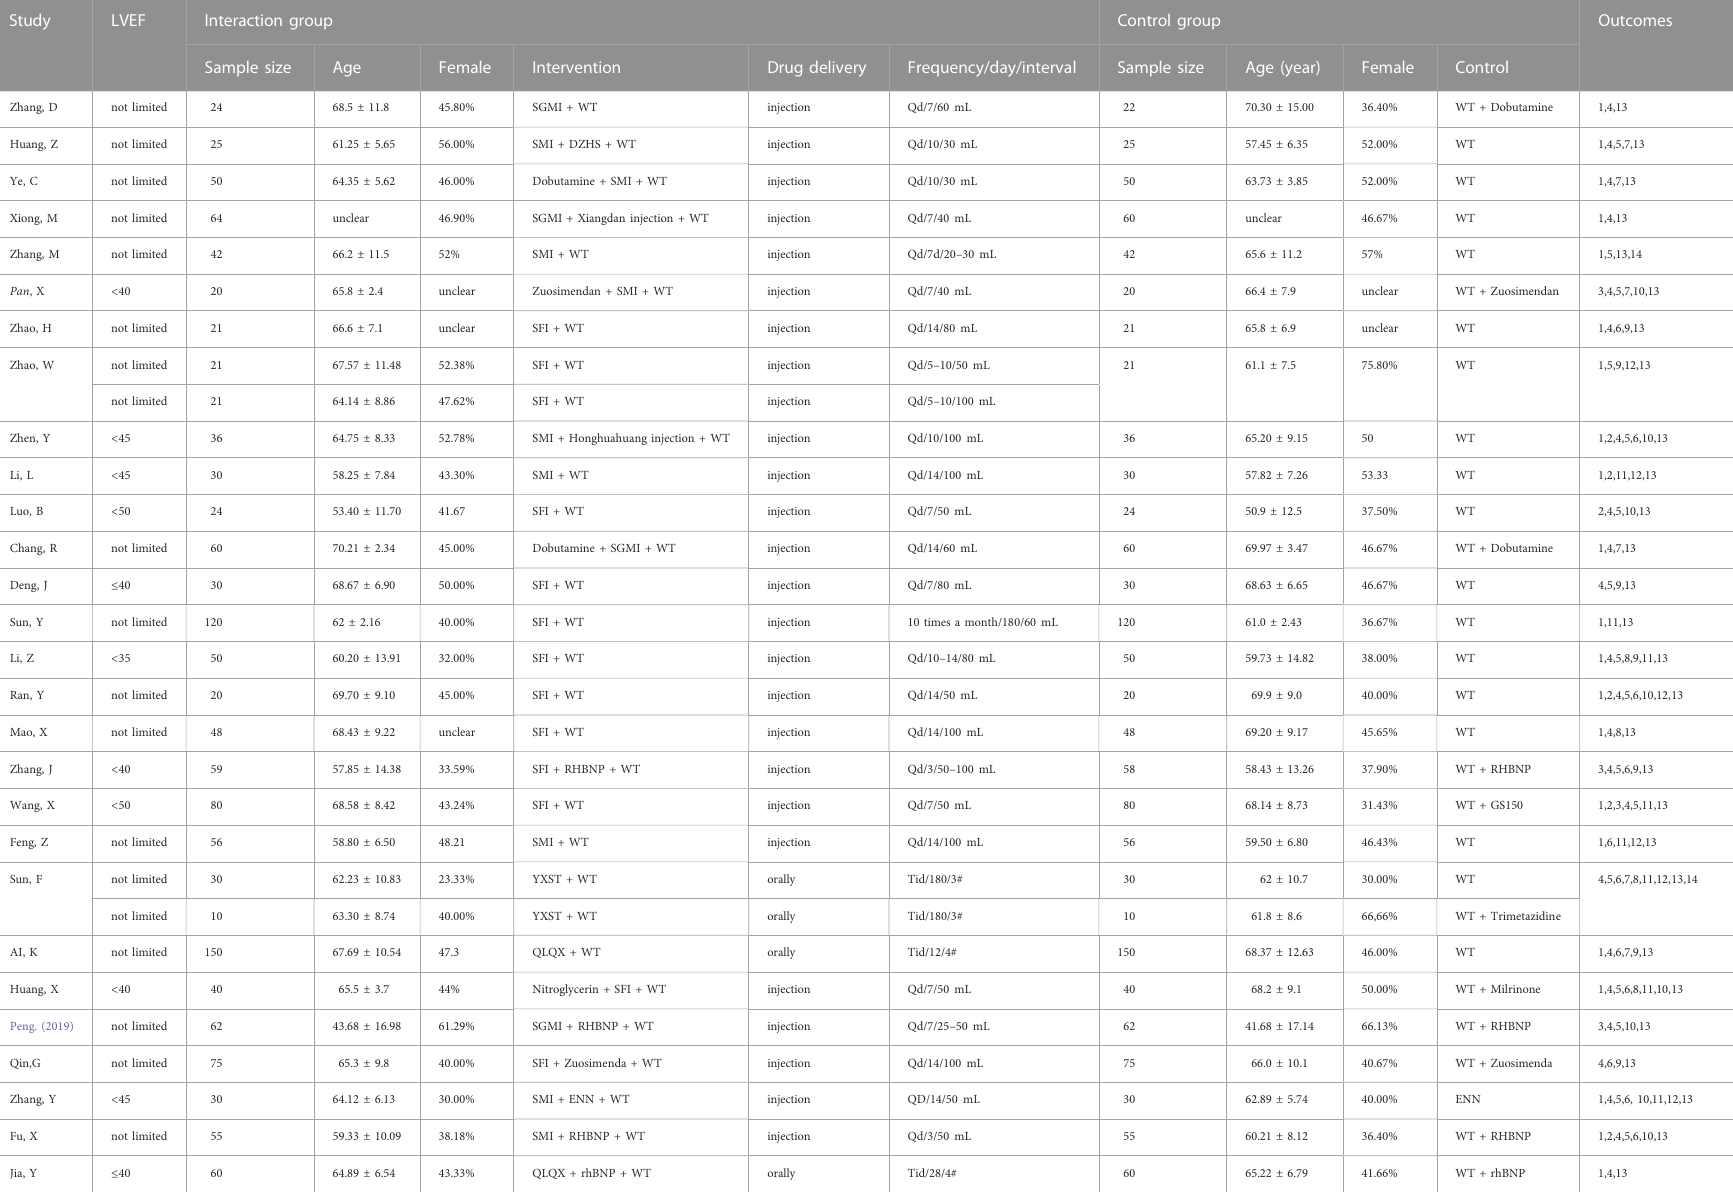
Outcomes: 1. HFES, 2; CSS, 3. Other Effective Measurement, 4. LVEF, 5. Adverse Reaction and Adverse Cases, 6. LVEDD, 7; SV, 8; LVEDV, 9. NT-proBNP, 10; BNP, 11.6MWT, 12; MLFHQ, 13. Mortality, 14.